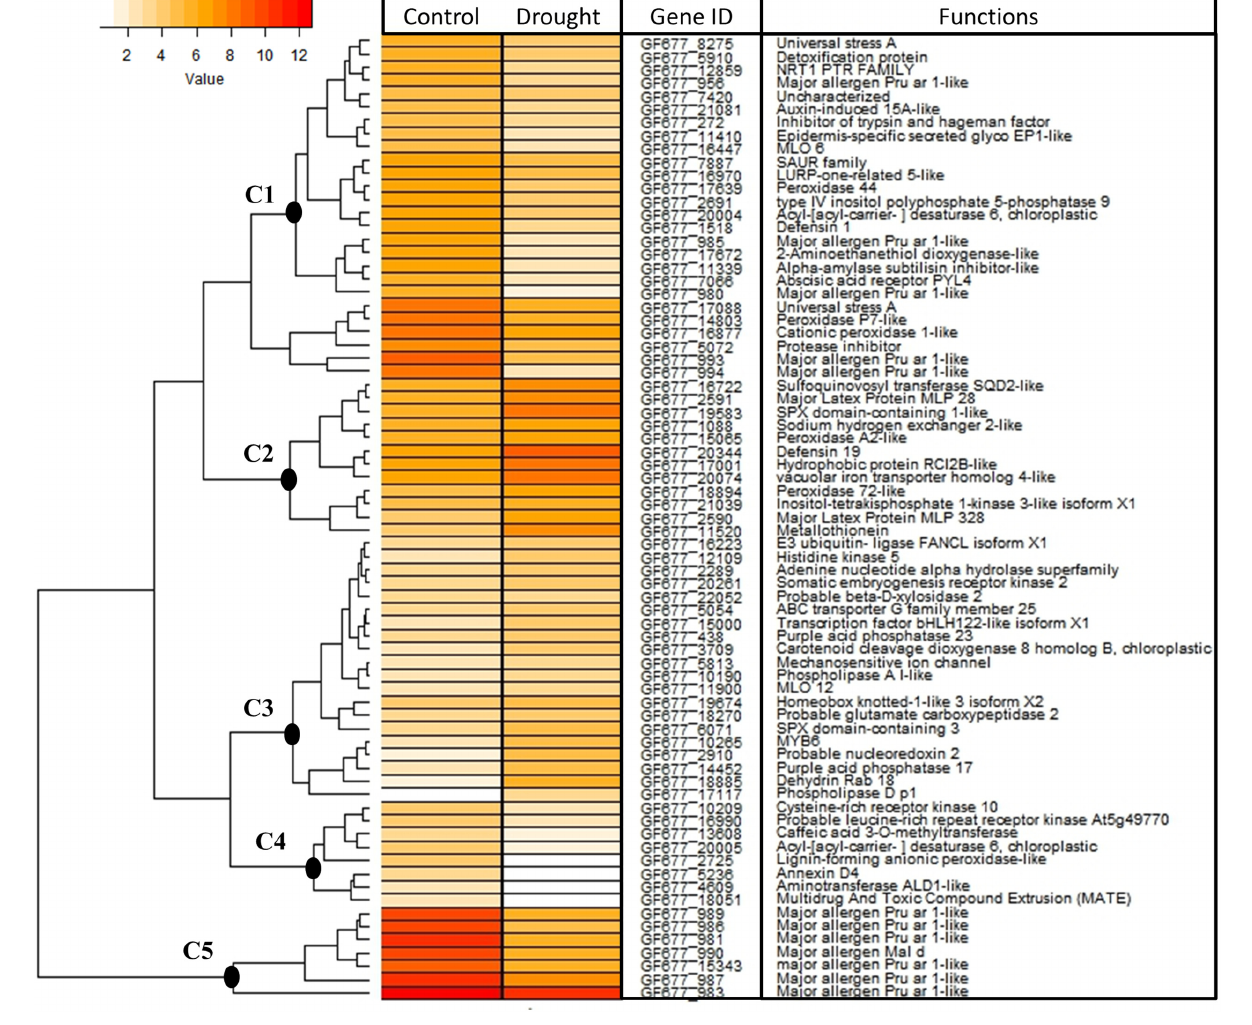
FIGURE 4 | Heat map of the DEGs in roots (GF677 rootstock) that are involved in “response to stimulus” (GO: 0050896). The colors indicate the abundance of transcripts calculated as Log 2 (RPKM + 1) in the control and drought-stressed plants (see color key). The main gene clusters are numbered from C1 to C5. Further information about each gene is provided in Supplementary Table S2, listed, and grouped in